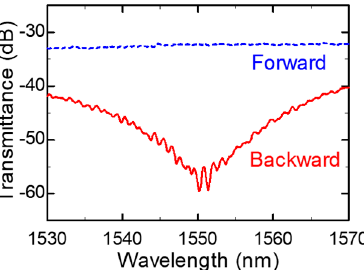
Figure 4. Measured transmission spectra of MZI isolator with a reciprocal phase shifter length L RPS of 3.7 µm.